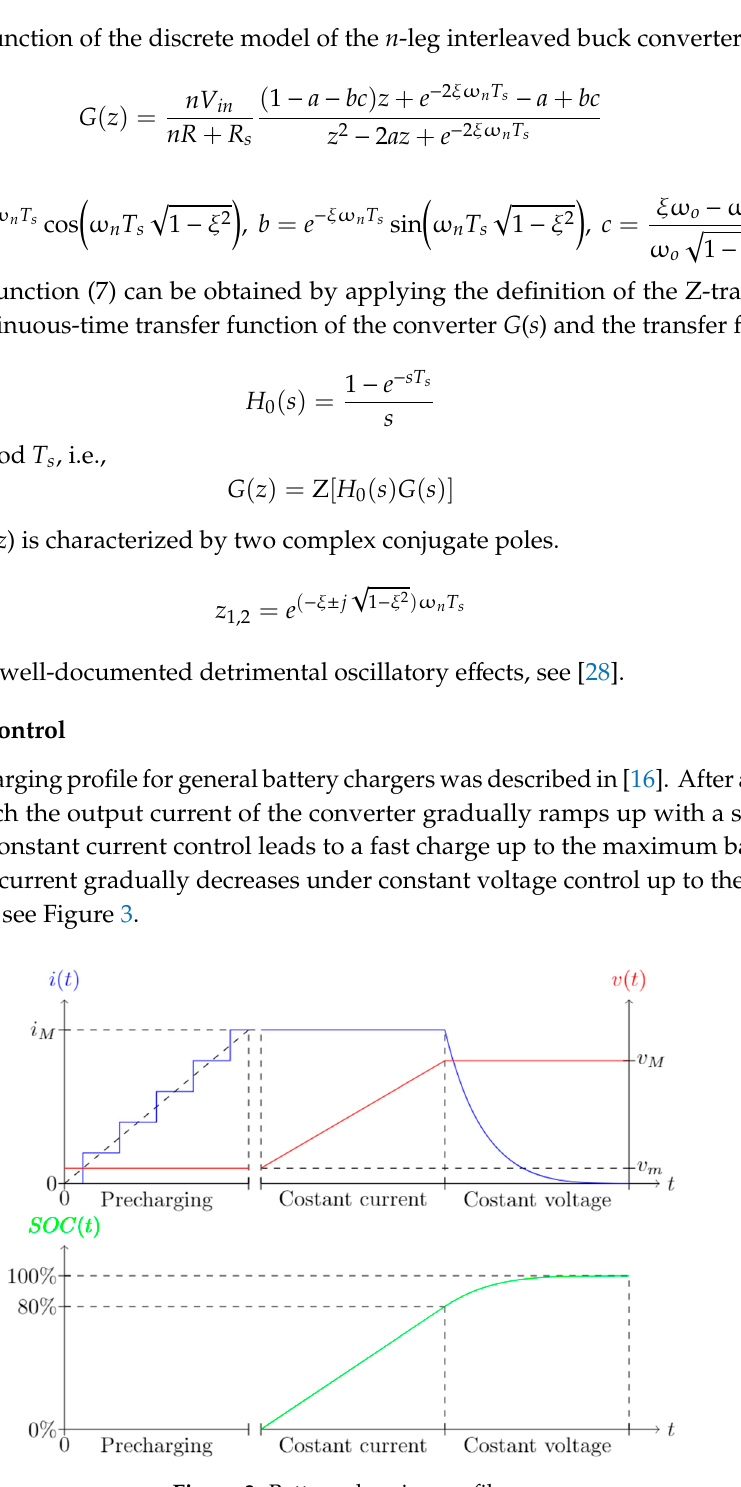
Figure 3. Battery charging profile.